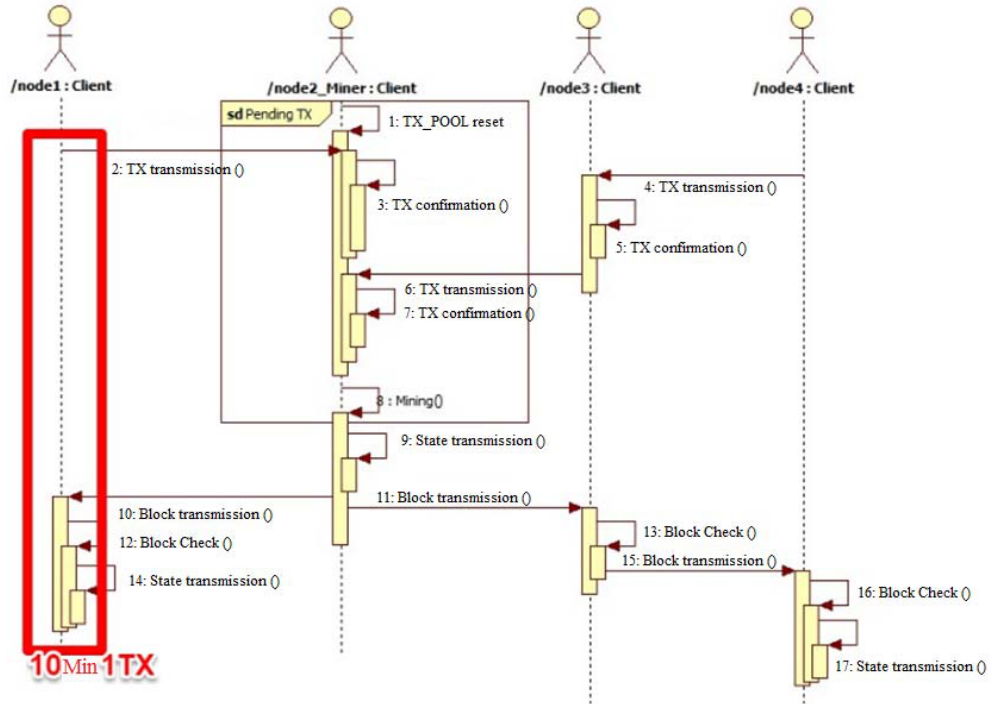
Figure 8. Rainbowchain Architecture Conclusion. TX: transaction.